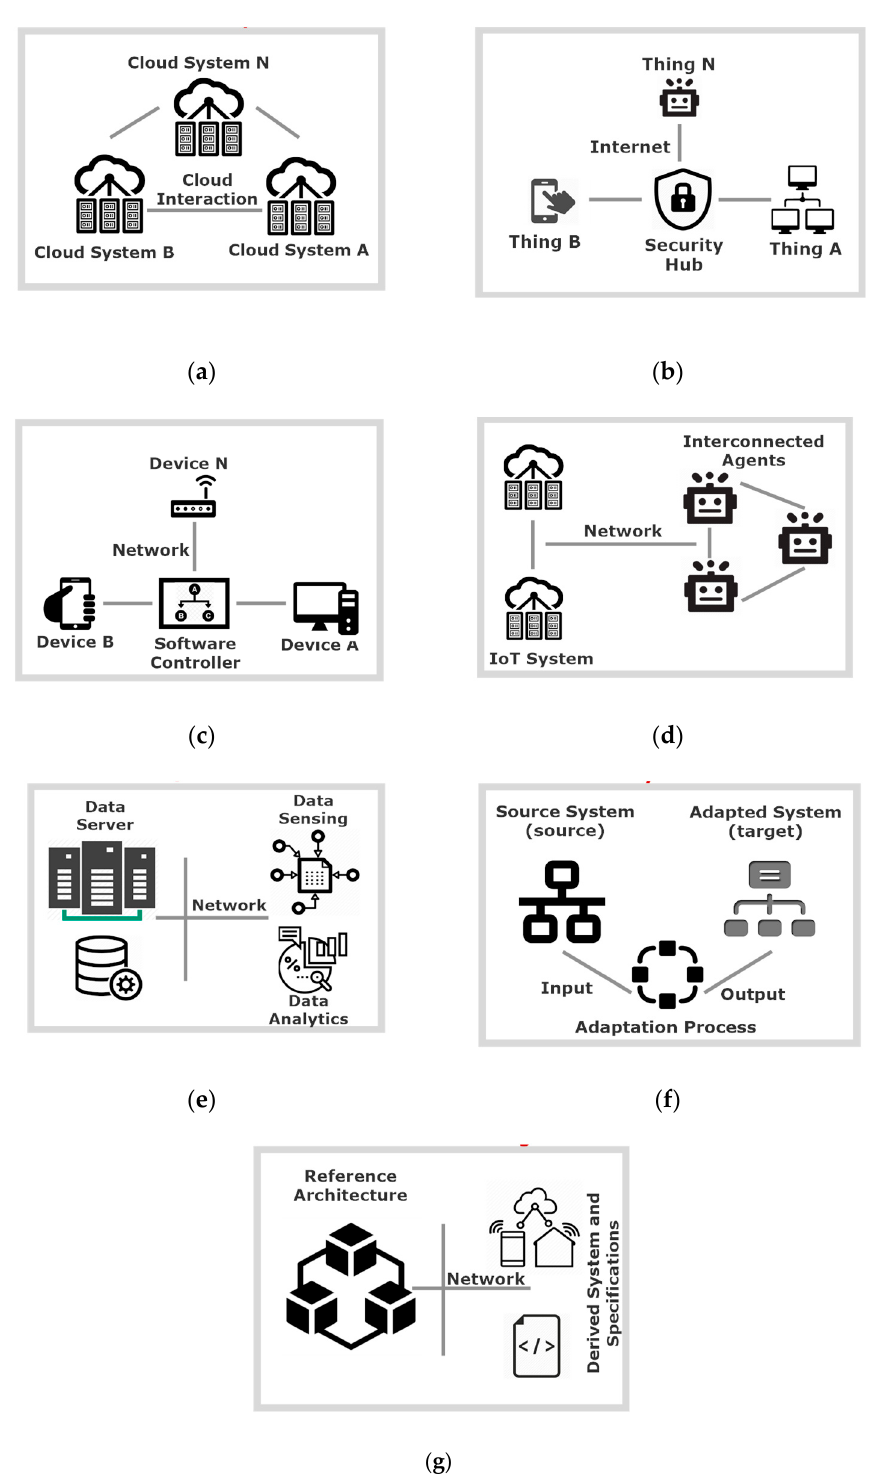
Figure 8. ( a ) Architectural View of Cloud Software Ecosystems. ( b ) Architectural View of Private and Secure IoTs. ( c ) Architectural View of SDN IoTs. ( d ) Architectural View of Agents Systems for IoTs. ( e ) Architectural View of IoT based Big Data Systems. ( f ) Architectural View of Autonomous and Adaptive IoTs. ( g ) Architectural View of IoT Reference Architectures.